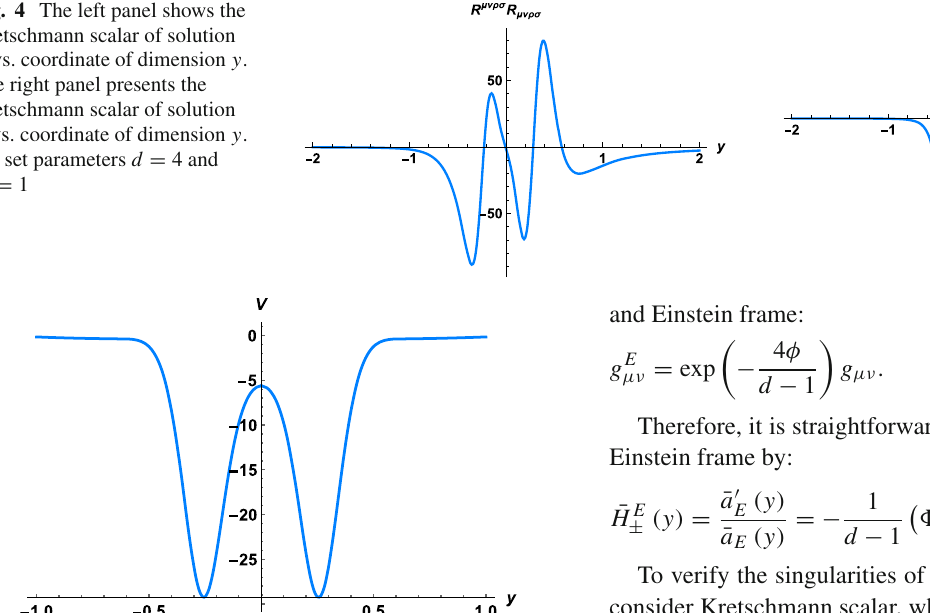
Fig. 4 The left panel shows the Kretschmann scalar of solution A vs. coordinate of dimension y . The right panel presents the Kretschmann scalar of solution B vs. coordinate of dimension y .